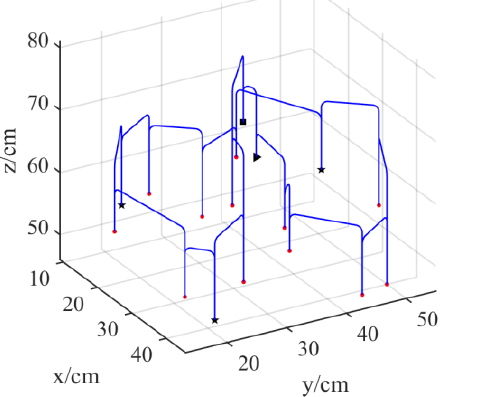
Figure 15. Result of the secondary path optimization.